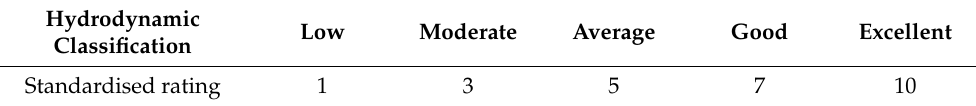
Table 2. Standardised rating scale.